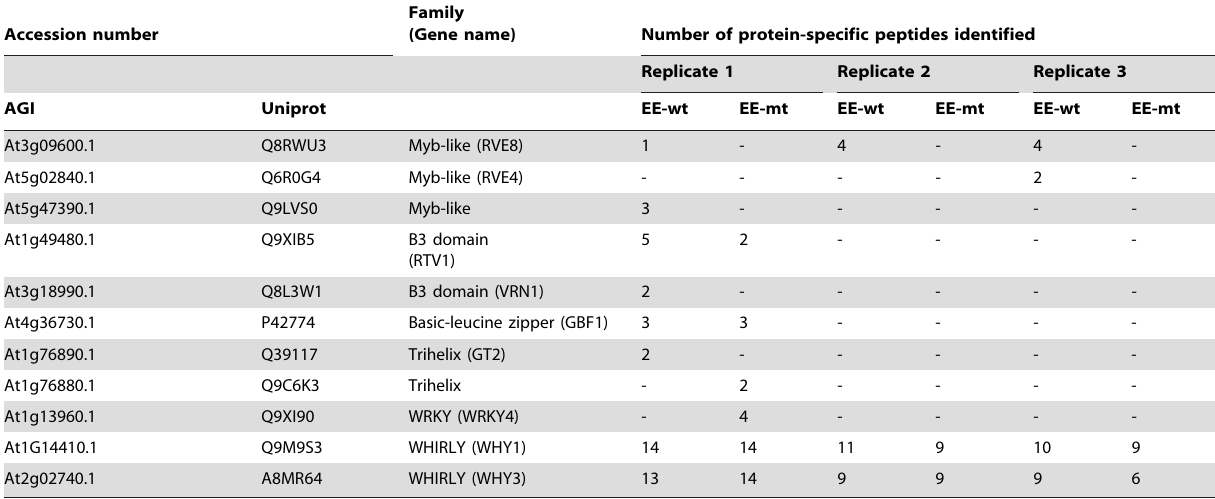
Table 1. Putative EE–binding factors identified by LC-MS/MS.